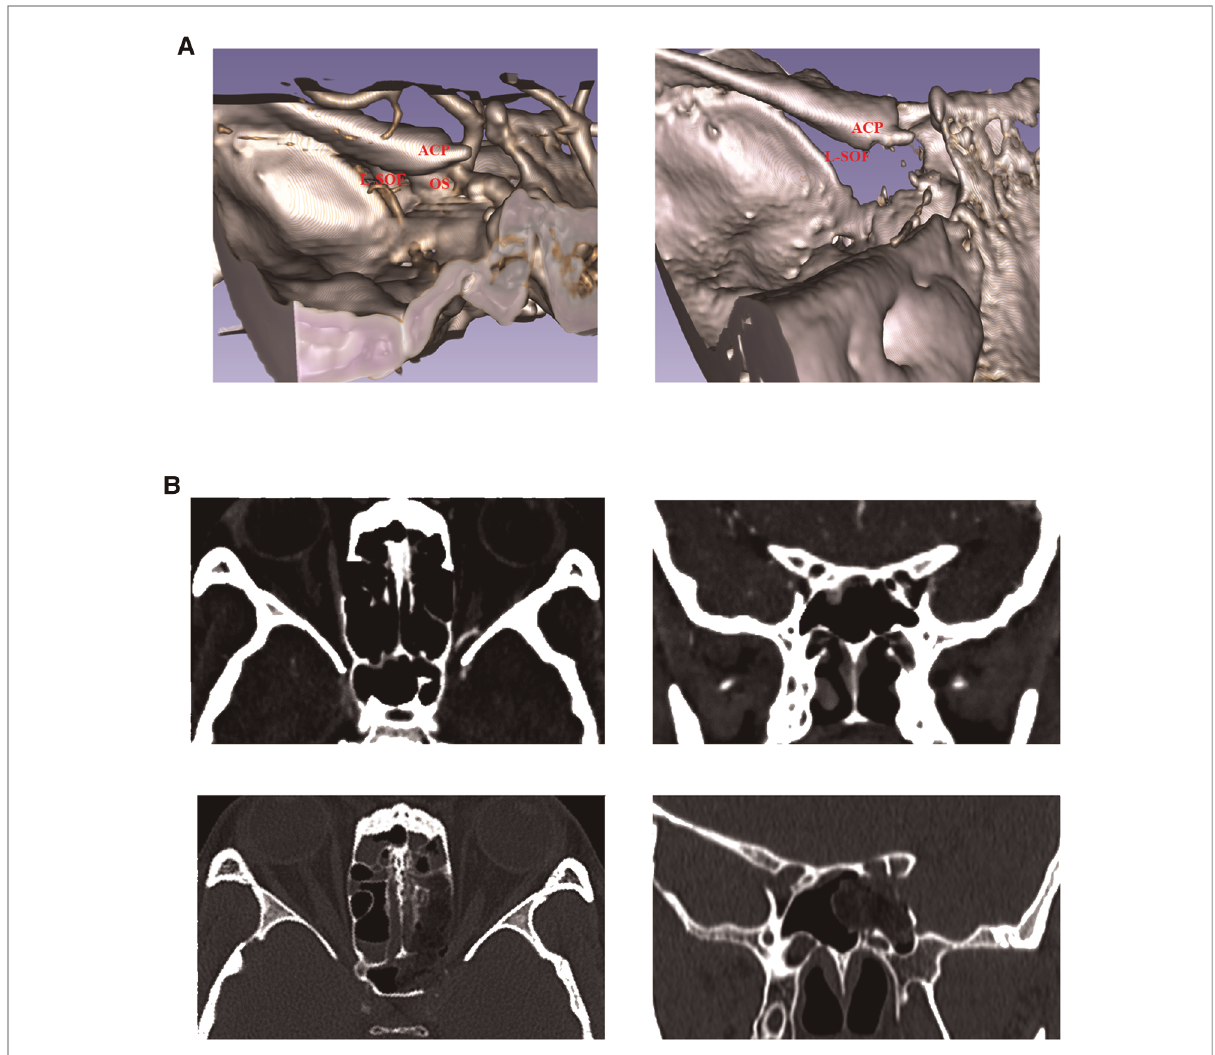
FIGURE 7 Comparison of preoperative and postoperative imaging data. ( A ) Observation of superior orbital fi ssure from the upper left of the skull base. Preoperative and postoperative 3D reconstruction images are shown on the left and right, respectively. It can be seen that the optic strut and part of the body of the sphenoid bone are resected. ( B ) Postoperative thin-slice CT reexamination. Left: Comparison of axial CT. Right: Comparison of coronal CT. Top: Preoperative images. Bottom: Postoperative